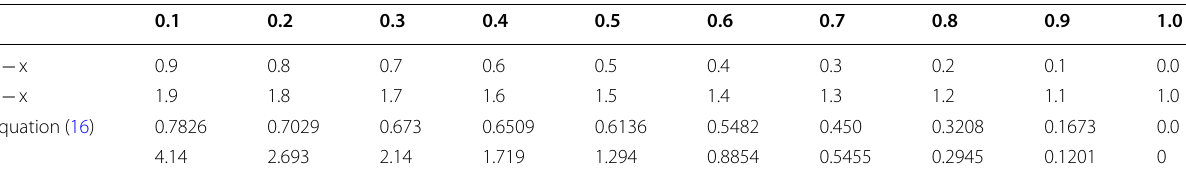
The graph of Table 3 entries in Fig. 16 enables x to be